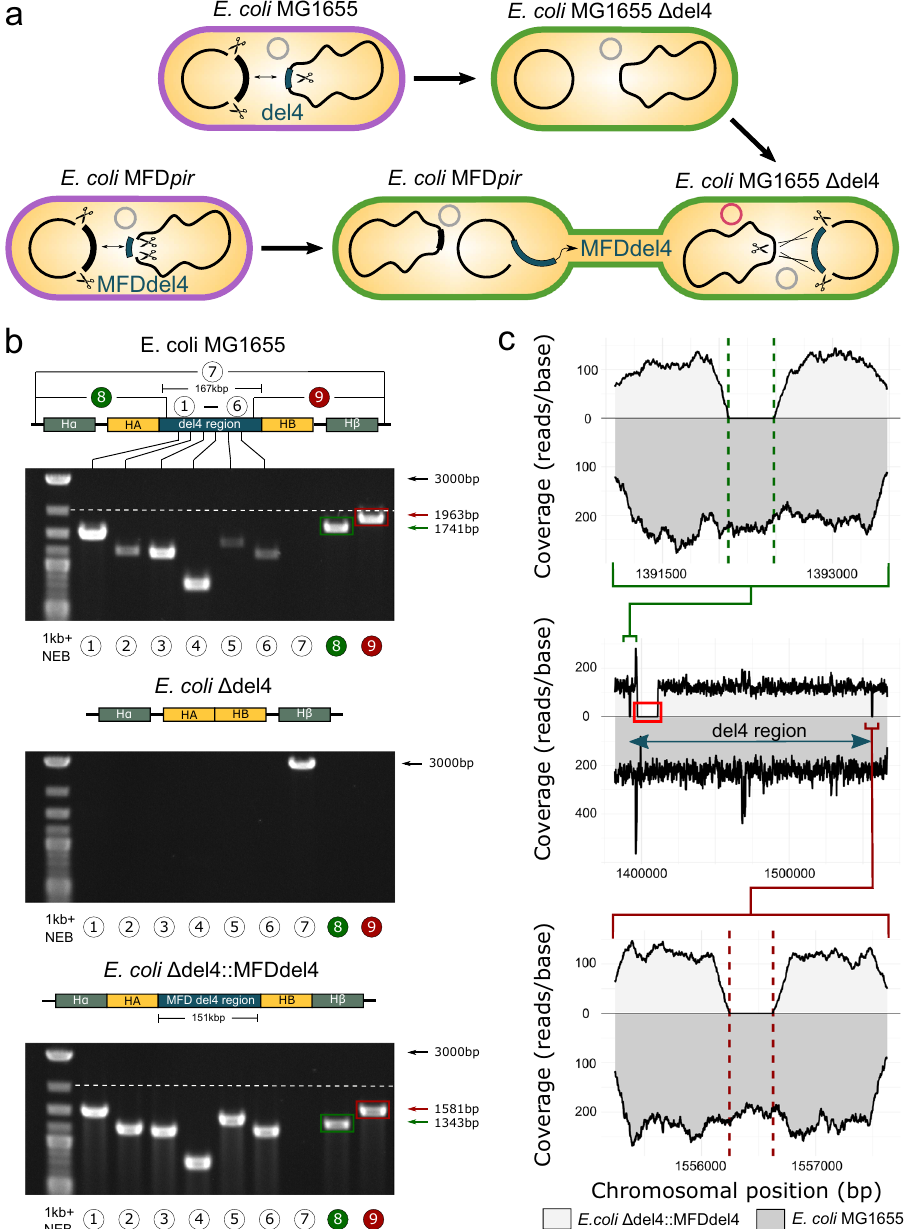
Fig. 6 Transfer and integration of a 151 kb chromosomal region via CRISPR SWAPnDROP. a Scheme of the deletion of the 167 kb del4 chromosomal region in E. coli MG1655 (top). Swap and conjugational transfer of the 151 kb MFDdel4 chromosomal region from E. coli MFD pir to E. coli MG1655 Δ del4 and subsequent integration (bottom). Cell colours represent the corresponding editing step. b Shown are agarose gels of PCRs from the integration of a 151 kb chromosomal region in E. coli . PCRs were done for E. coli MG1655 (acceptor precursor), the acceptor ( E. coli MG1655 Δ del4) and the edited strain ( E. coli MG1655 Δ del4::MFDdel4). PCRs “ 1 – 6 ” result in the ampli fi cation of fragments of the del4 region evenly distributed over the 167 kb ( E. coli MG1655) and 151 kb ( E. coli MFD pir ), respectively. PCR “ 7 ” result in the ampli fi cation of a 3000 bp fragment, if the del4 region is missing. PCR “ 8 ” and “ 9 ” amplify the transition of the del4 region to the adjacent chromosomal regions. Upon integration of the 151 kb MFDdel4 region into the E. coli MG1655 Δ del4 chromosome, small regions fl anking the 151 kb region were deleted resulting in DNA bands of lower size compared to the wild-type chromosome. This is additionally highlighted with the colours green and red. Dashed line indicates the band size of a 2000 bp DNA fragment for a better comparison. PCR was repeated once with identical results. Chromosomal overviews including homologous regions (HA, HB, H α , H β of each PCR are shown above each agarose gel. c Shown is the next-generation sequencing (NGS) coverage (reads/base) of E. coli MG1655 Δ del4::MFDdel4 (light grey) and E. coli MG1655 (dark grey) mapped against the E. coli MG1655 reference genome. The middle plot shows the coverage of the del4 region. For E. coli MG1655 Δ del4::MFDdel4, reads for the 16 kb deletion, only present in the integrated MFDdel4 region, are missing (red rectangle). The upper and lower plots showing the detailed coverage of the del4 fl anking regions. Upon integration of the MFDdel4 region, small fl anking regions were deleted, shown as missing reads between the dashed